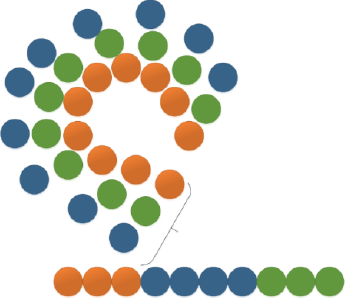
Figure 8. Multi-parent Crossover strategy with three solutions.